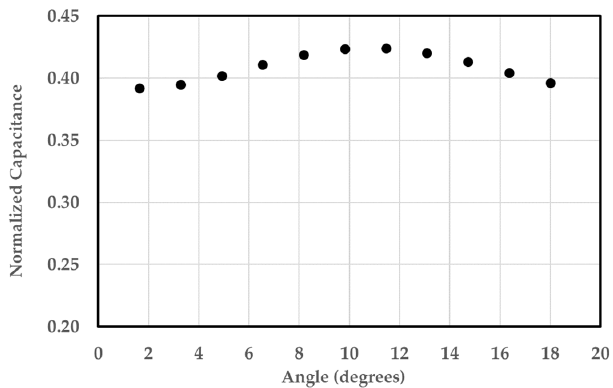
Figure 14. Effect of the relative angle between the two bubble sets on the normalized capacitance.